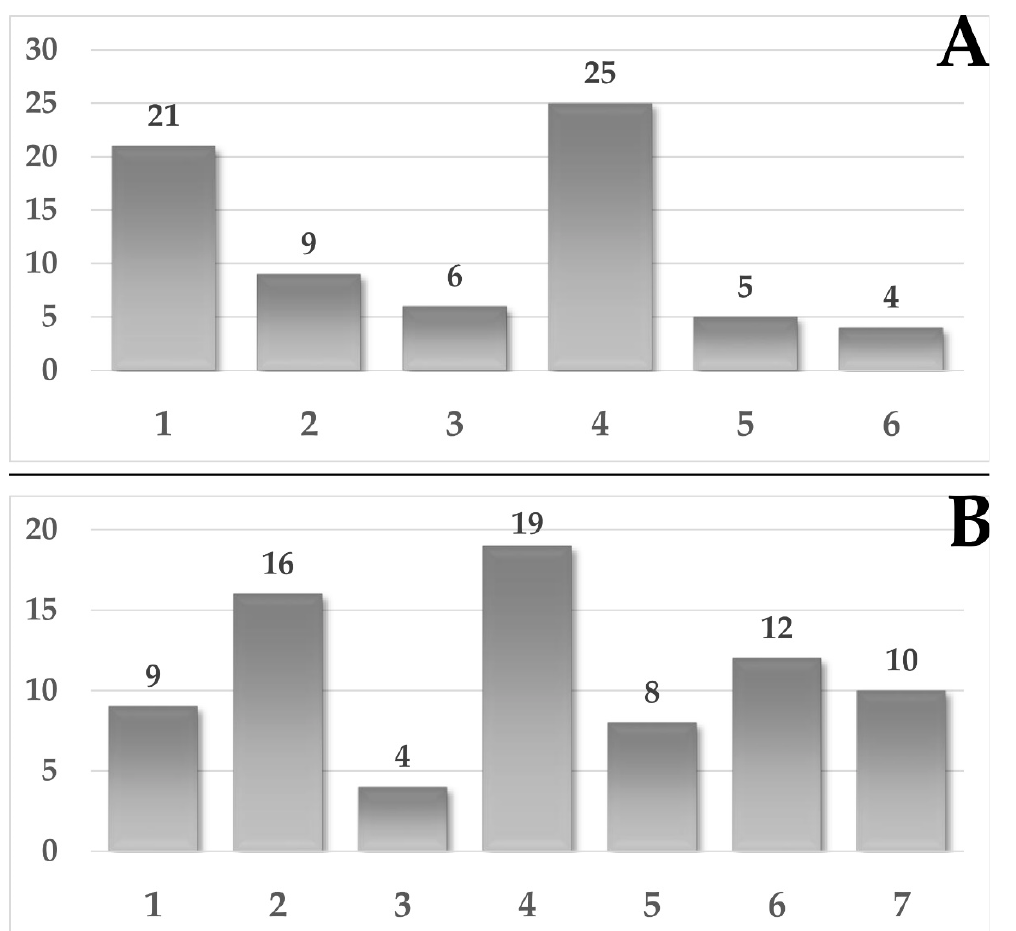
Figure 3. ( A )—Used research methods: 1—Vegetation indices, 2—Soil moisture indices and Groundwater table, 3—Water indices and Water table depth, 4—Supervised classification and Ma- chine learning land cover classification, 5—Gross Primary Productivity, 6—Ground deformation; ( B )—The main focus of the research: 1—Monitoring of peatlands state, 2—Changes in water condi- tions in the peatland and monitoring soil moisture in peatlands, 3—Estimating balance of green- house gases, 4—Land classification/identification of peatlands, 5—Estimating carbon resources in peatlands, 6—Peatland vegetation mapping, 7—Monitoring of peatland state, based on Table 1.